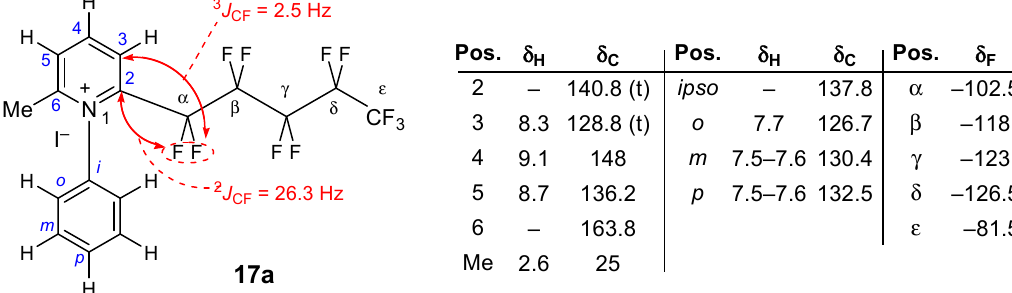
Figure 1. Structure of 6-methyl-2-perfluoropentyl-1-phenylpyridinium 17a and NMR resonance assignments.